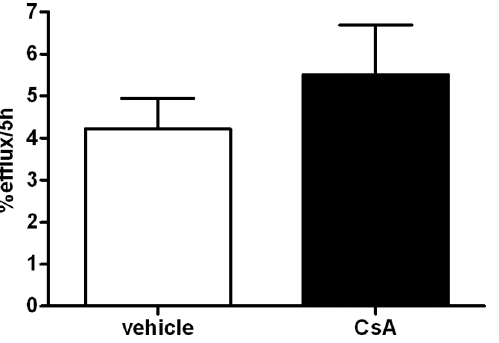
Figure 5. CsA treatment effect on plasma cholesterol efflux capacity. MPM were cholesterol enriched with 25 m g/ml AcLDL and radiolabeled with [ 3 H]-cholesterol 2 m Ci/ml. After an equilibration period of 18 hours, cells were exposed for 5 hours to 0.5% plasma from mice treated with CsA or vehicle as described in Figure 1. Efflux is expressed as cpm in medium/cpm of time zero x100 (values are mean of 7 animals per group 6 SD).